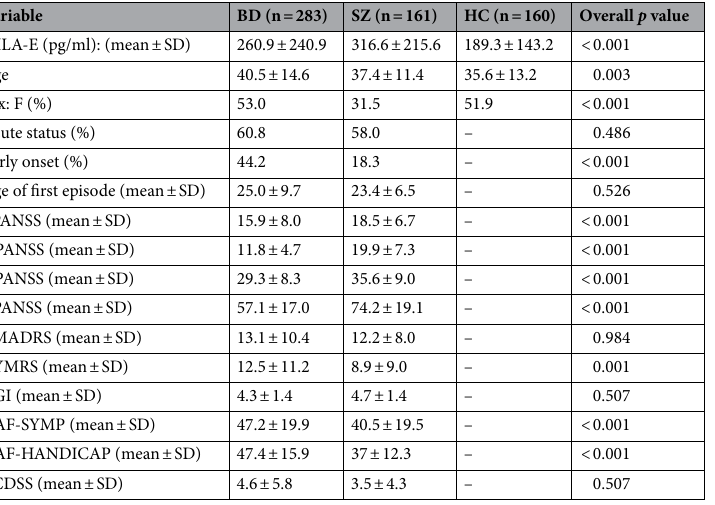
Table 1. Demographic and clinical characteristics of the study subjects. Psychotic symptoms were assessed using the positive and negative syndrome scale (PANSS); positive PANSS (PPANSS); negative PANSS (NPANSS); Global PANSS (GPANSS); Total PANSS (TPANSS). All patients were evaluated for mania with the Total Young Mania Rating Scale (TYMRS). Depression was scored using the Total Calgary Depression Scale (TCDSS) and the Total Montgomery-Asberg Depression Rating Scale (TMADRS). General functioning was assessed with the Global Assessment of Functioning Scale (GAF); GAF symptom score (GAF-SYMP) and GAF Handicap score